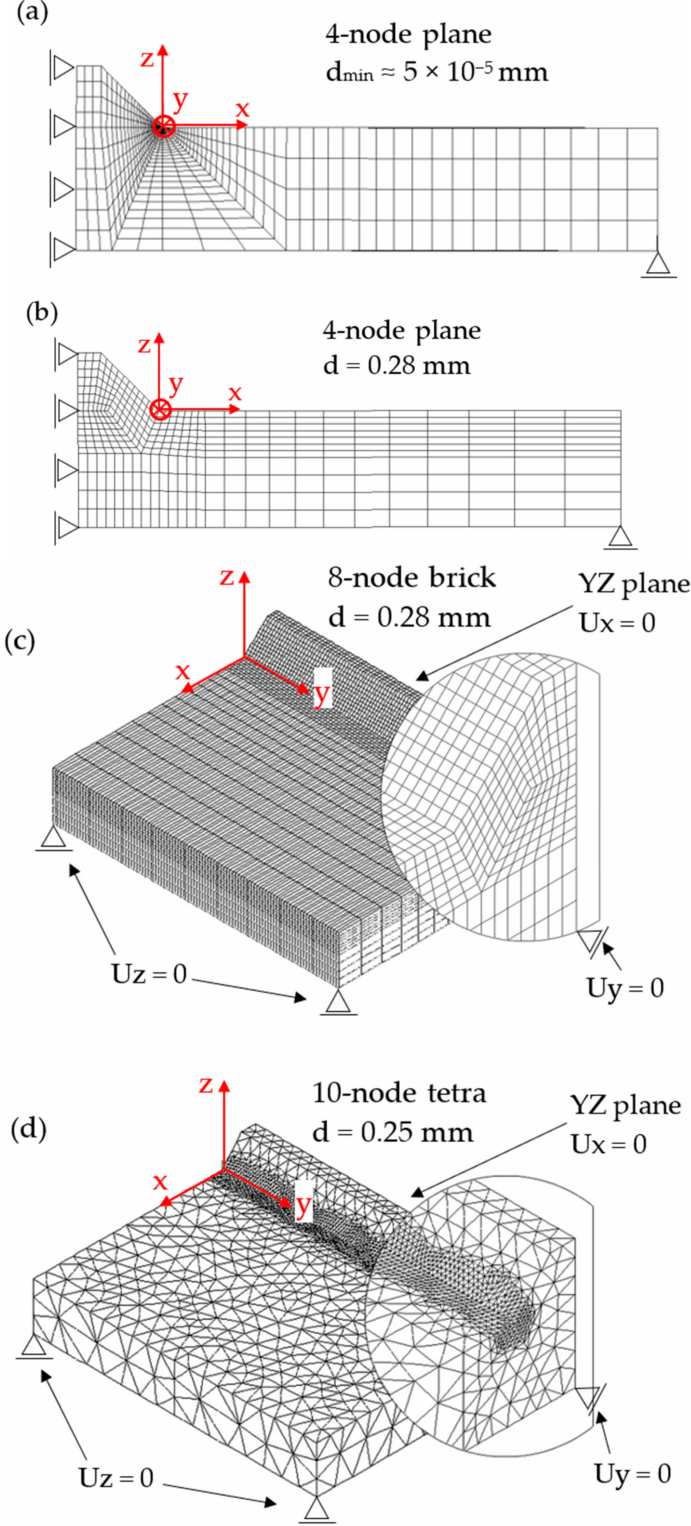
Figure 5. ( a ) Refined FE model: 2D mapped mesh with 4-node plane elements. Coarse FE models: ( b ) 2D mapped mesh with 4-node plane elements; ( c ) 3D mapped-mesh with 8-node brick elements, obtained by extruding the 2D mesh; and ( d ) 3D free mesh with 10-node tetra